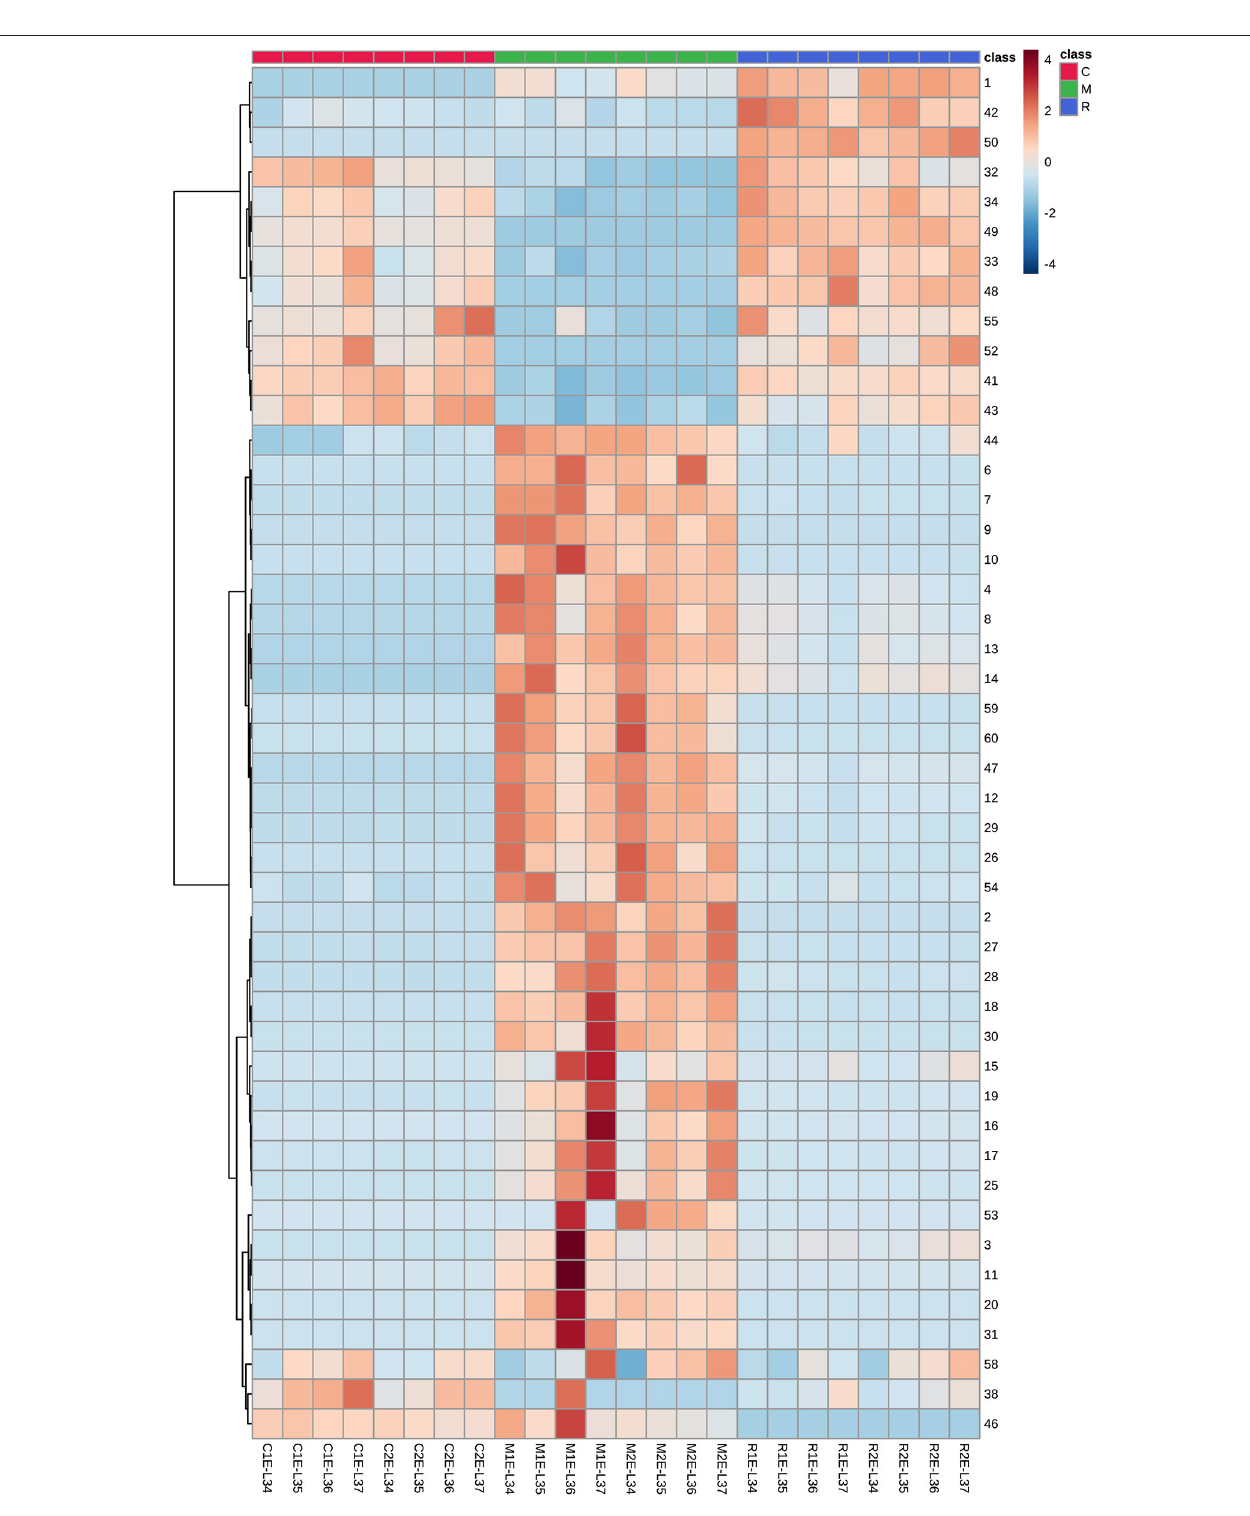
Frontiers in Plant Science |